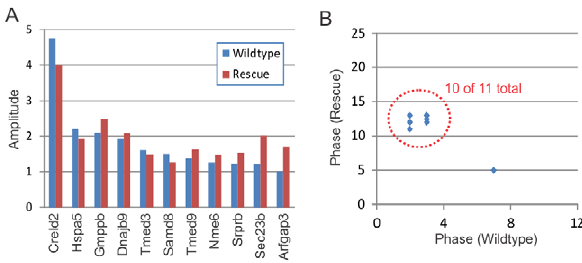
Figure 7. Clock-rescue restores normal amplitude and phase to circadian harmonics. Panel (A) shows the amplitude of circadian harmonics in wildtype (blue) and Clock -rescue (red) animals. In every case, there was no obvious diminishment of amplitude in the rescue animals. Panel (B) plots the phase of these rhythms in wildtype (x-axis) versus Clock -rescue (y-axis). 10 of the 11 total genes had similar phases in both genotypes. doi:10.1371/journal.pgen.1002835.g007 PLoS Genetics |